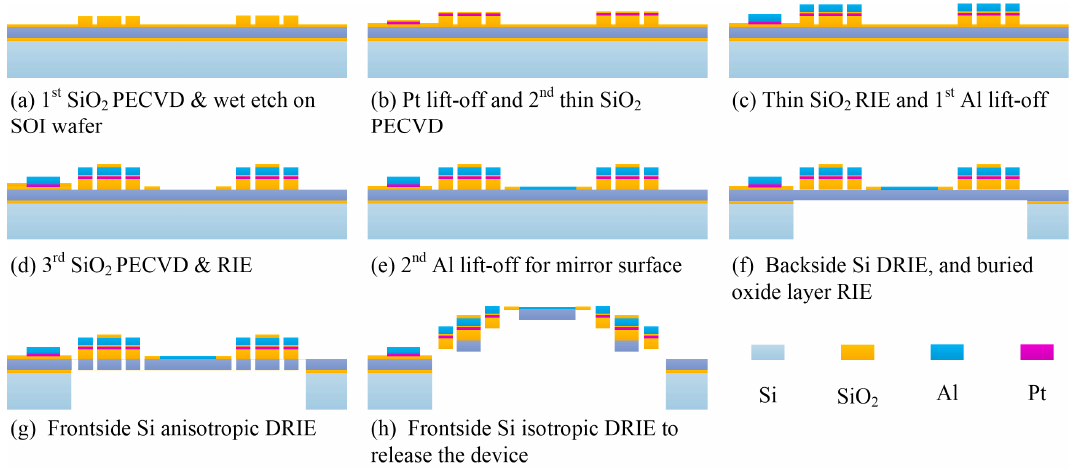
Figure 3. The fabrication process of the MEMS mirror. Table 2. The structural parameter of the MEMS device.